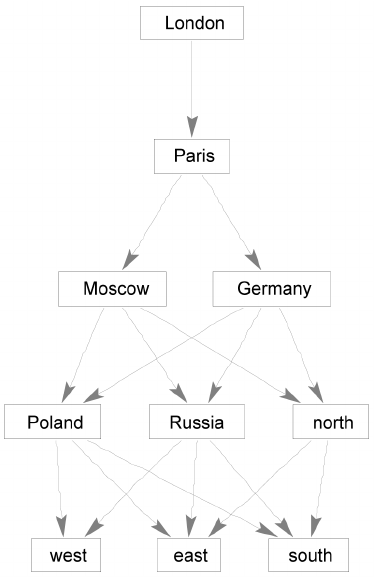
Figure 8. Joint invariant partial order for London relative to the set of words { London, Moscow, Paris, north, south, east, west, Germany,Poland,Russia }. Brain data derived from Figure 1 and the LSA data from Figure